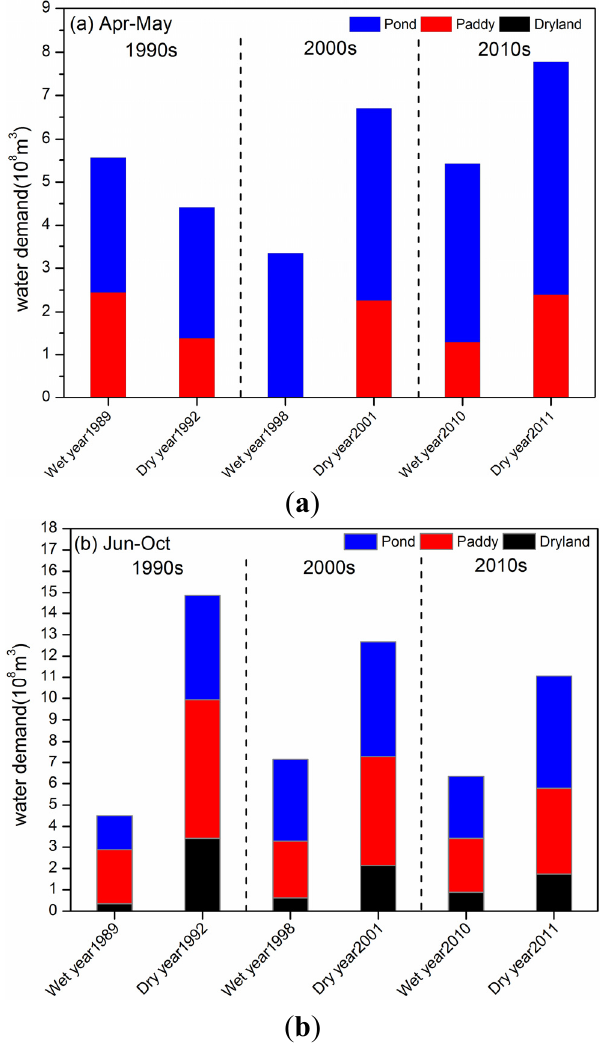
Figure 6. Water demands for three types of land use in the ( a ) April-May and ( b ) June-October periods of representative wet and dry